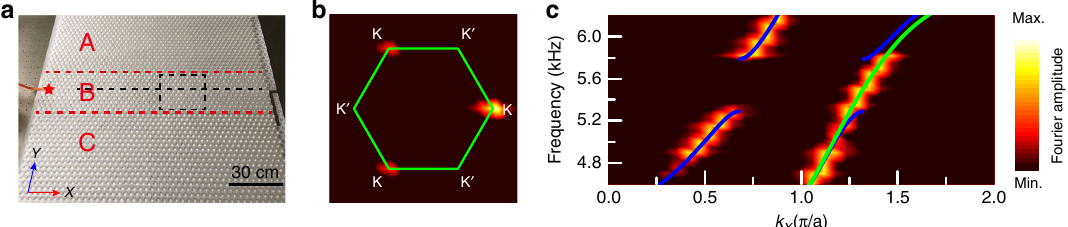
Fig. 2 Experimental measurement of TVWSs in the waveguide with x = 11. a Photo of the sample, with the red star indicating the point source, operated by opening of a small rubber pipe, which injects the acoustic waves. b Fourier spectrum by color at a frequency of 5.55 kHz, obtained by Fourier transforming the measured fi eld distribution inside the rectangle delineated by the black dashed lines in a ; the green solid lines indicate the hexagonal fi rst Brillouin zone. c Experimentally measured dispersions (colors) compared with the simulated ones: the green line indicates the TVWSs, and the blue lines indicate the other waveguide states.